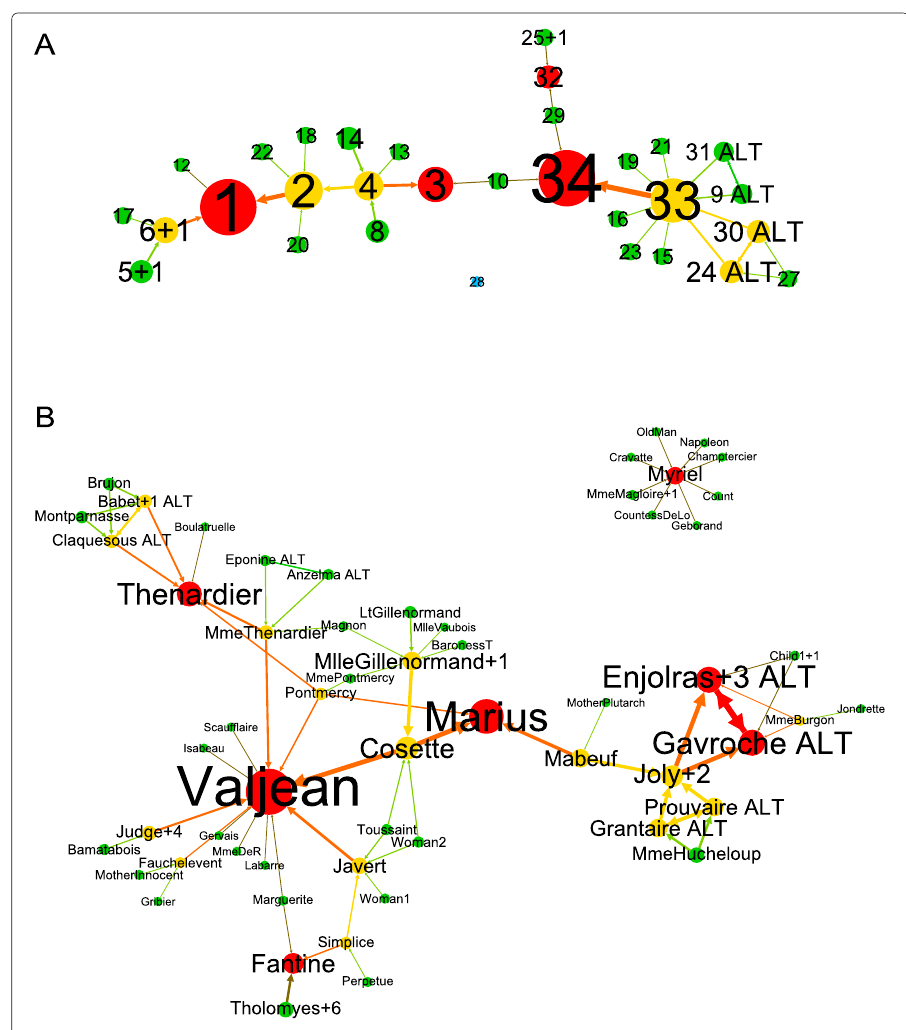
Fig. 7 Karate Club ( a ) and Les Misérables ( b ) zone networks. The networks were transformed into the weighted directed networks of sub-zones and zones nested in overlaps. Each pair of nodes in this transformed network connected by a directed edge represents zones; the smaller node represents the sub-zone that is nested into the super-zone represented by the larger node. The size of each zone corresponds to the number of nodes in this zone, and the edge strength corresponds to the number of nodes of the sub-zone. Red nodes represent zones that have no super-zone, green ones zones without sub-zones. The yellow zones have both sub-zones and super-zones, and blue zones have neither sub-zones nor super-zones. In sub-figure a with Karate Club, there is a multi-ego zone (node 6+1) with two egos 6 and 7, one liaison 1 and three other nodes 5, 11, 17 (see also Fig. 2). Moreover, there are, e.g., two alternative zones with egos 9 or 31 (9 ALT or 31 ALT). The first one has one liaison, 34, one co-liaison, 33, and one other node, 31. The second one has the same liaison, 34; however, it has two co-liaisons, 9, 33, and no other node. Similarly, in sub-figure b , Enjolras’s zone has three other egos and one alternative Gavroche’s zone. If the zone has at least two edges directed to different zones, then it is contained in their overlap. While in Karate Club, there are no zones nested in overlaps, the Les Misérables network has, for instance, such zones for Cosette, Pontmercy, and